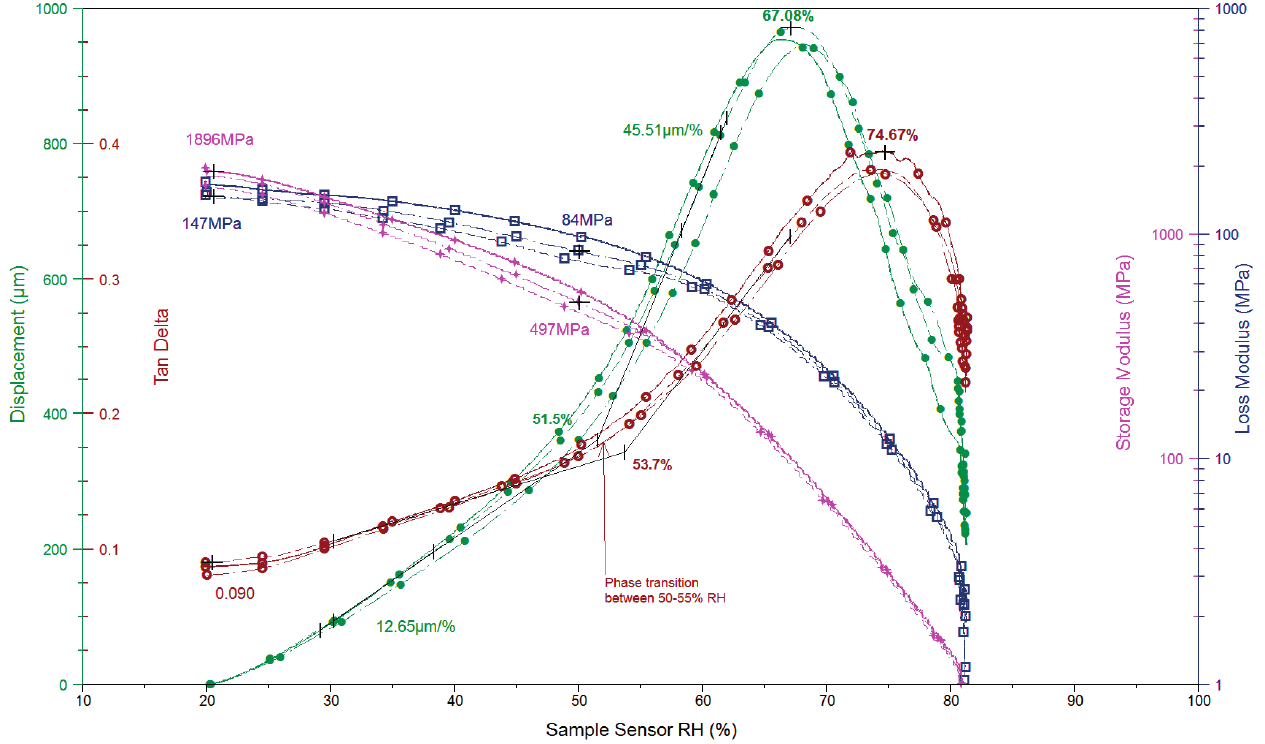
Figure 7. Isothermal RH-ramp on ~0.04 mm CaCas/Gly films after 6 h equilibration at 20 °C and 20% RH; triplicate performed after 4, 5 and 6 days in storage at 20 °C and 50% RH. Legend: green ( ● ) = d ; pink ( + ) = E '; dark blue ( □ ) = E ''; brown ( ○ ) = Tan δ